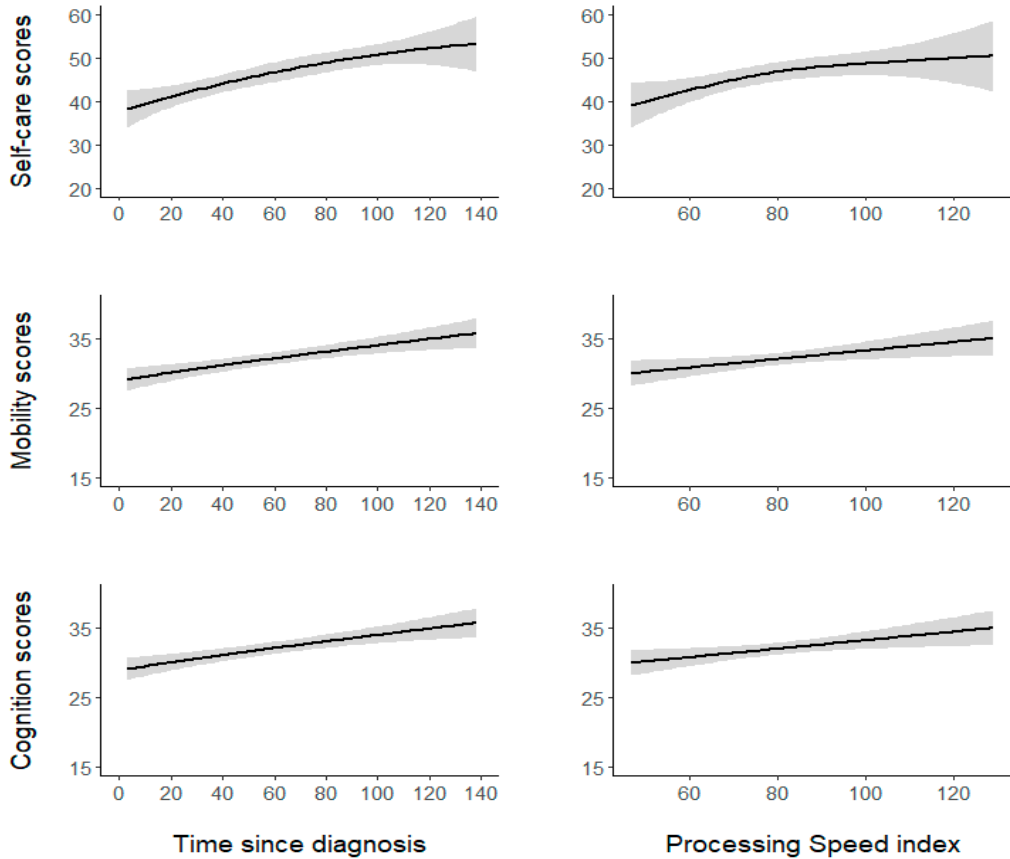
Figure 1. The nonlinear and linear relationships between the significant continuous predictors (time since diagnosis and the PS index) and the WeeFIM self-care, mobility, and cognition subscales. The shaded grey areas represent the SE.